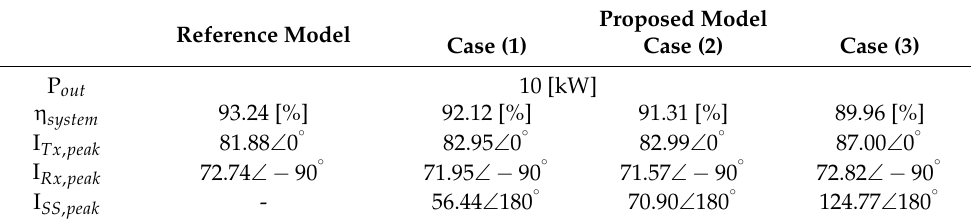
Table 4. Output power, power transfer efficiency, and current of the comparison models.